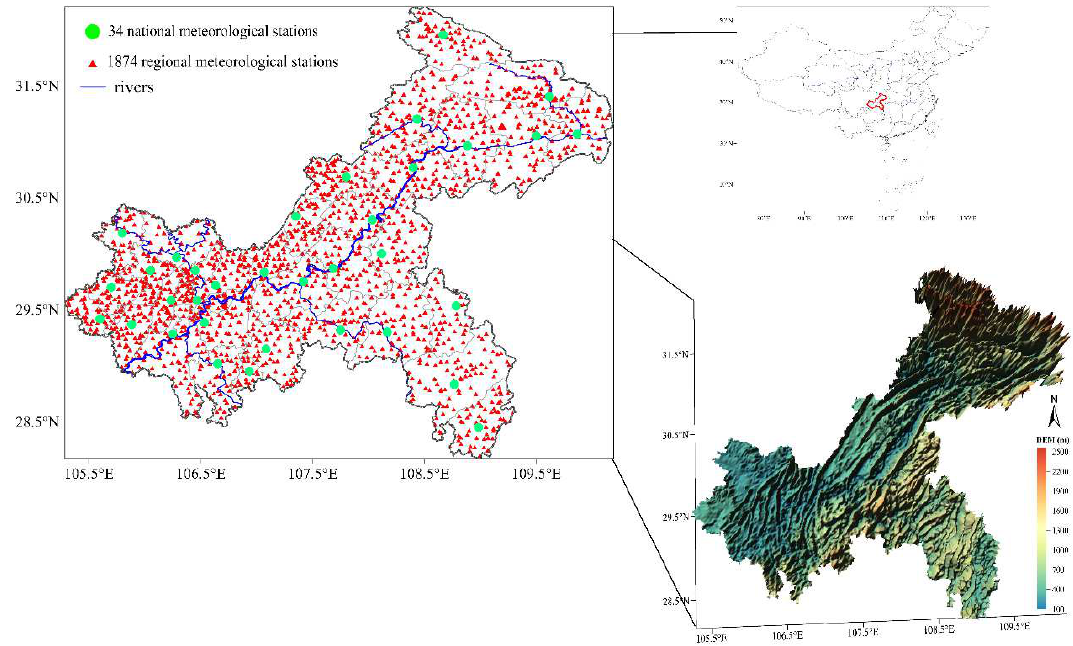
Figure 1. Geographical location of Chongqing in China, distribution of high-density meteorological stations in Chongqing, and digital elevation model (DEM) map of Chongqing (The green dots indicate 34 national meteorological stations, and the small red triangles indicate 1874 regional meteorological stations).